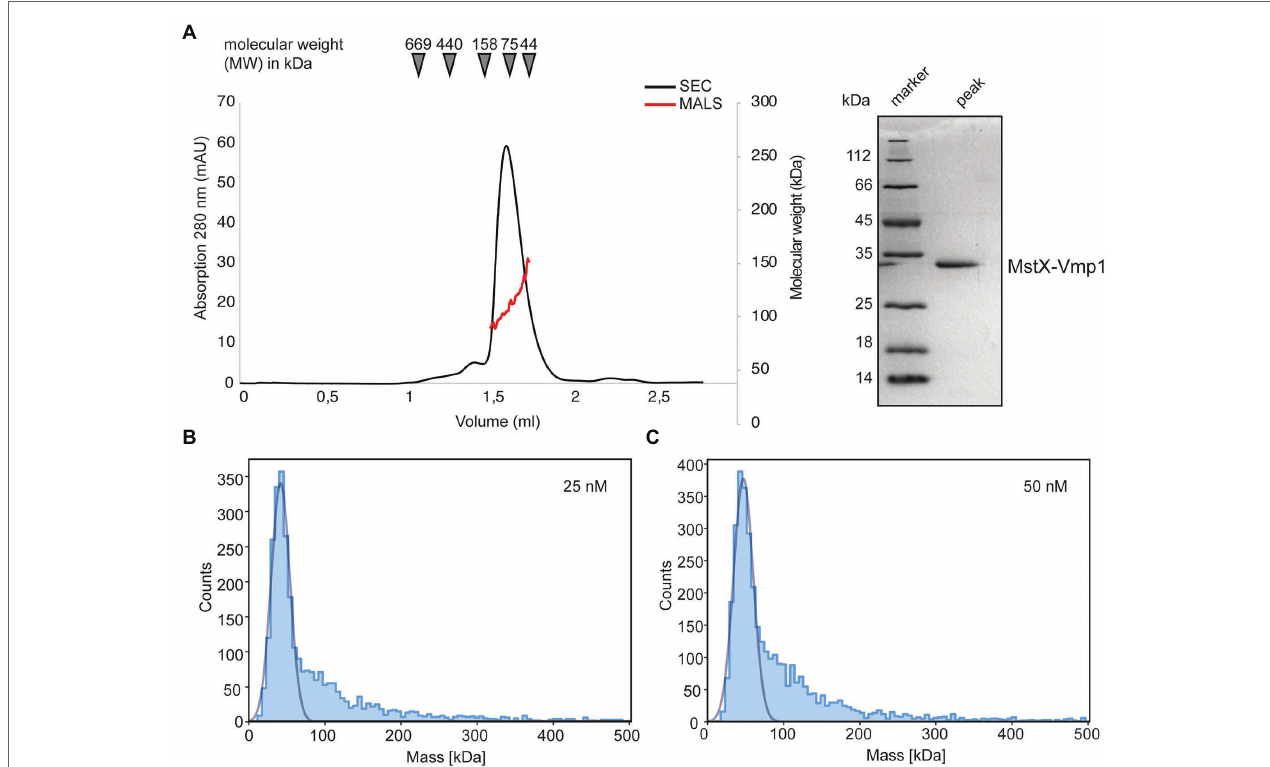
FIGURE 5 | Biochemical analysis of Vmp1. (A) Multi-angle-light scattering coupled size-exclusion chromatography (SEC-MALS) of full length MstX-Vmp1. The black line depicts the absorption at 280 nm, while the red line corresponds to the molecular weight as determined by MALS. The inset shows a SDS-PAGE of the peak fraction. (B,C) Mass photometry of Vmp1 in 0.1% LDAO at 25 and 50 nM concentration,